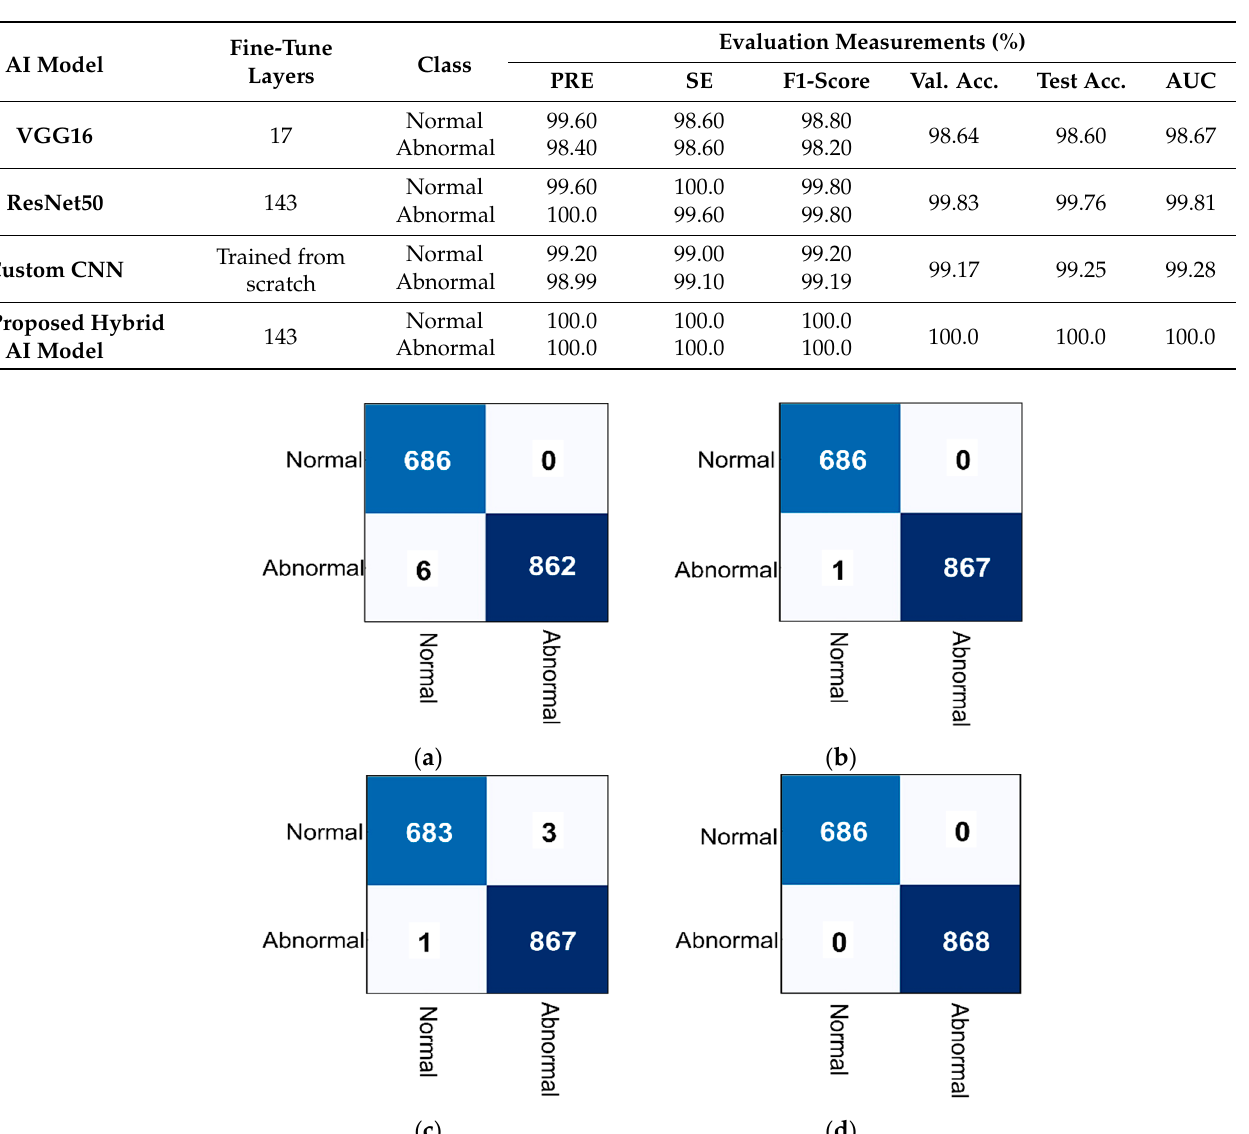
Table 7. Scenario A evaluation performance via four AI models using Dataset 1 without cross-validation.